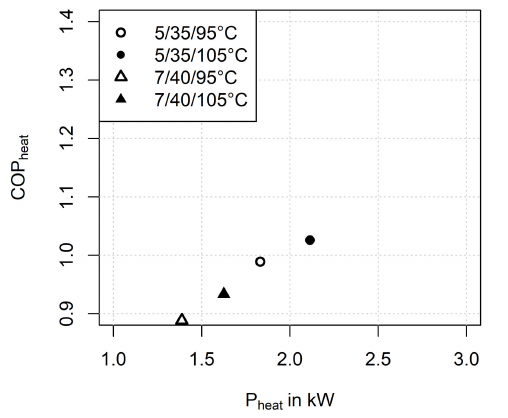
Figure 15. Efficiency and power for 5/35 ◦ C and 7/40 ◦ C temperature conditions and two different driving temperatures (95 ◦ C and 105 ◦ C). A small improvement in terms of efficiency is possible with an elevated driving